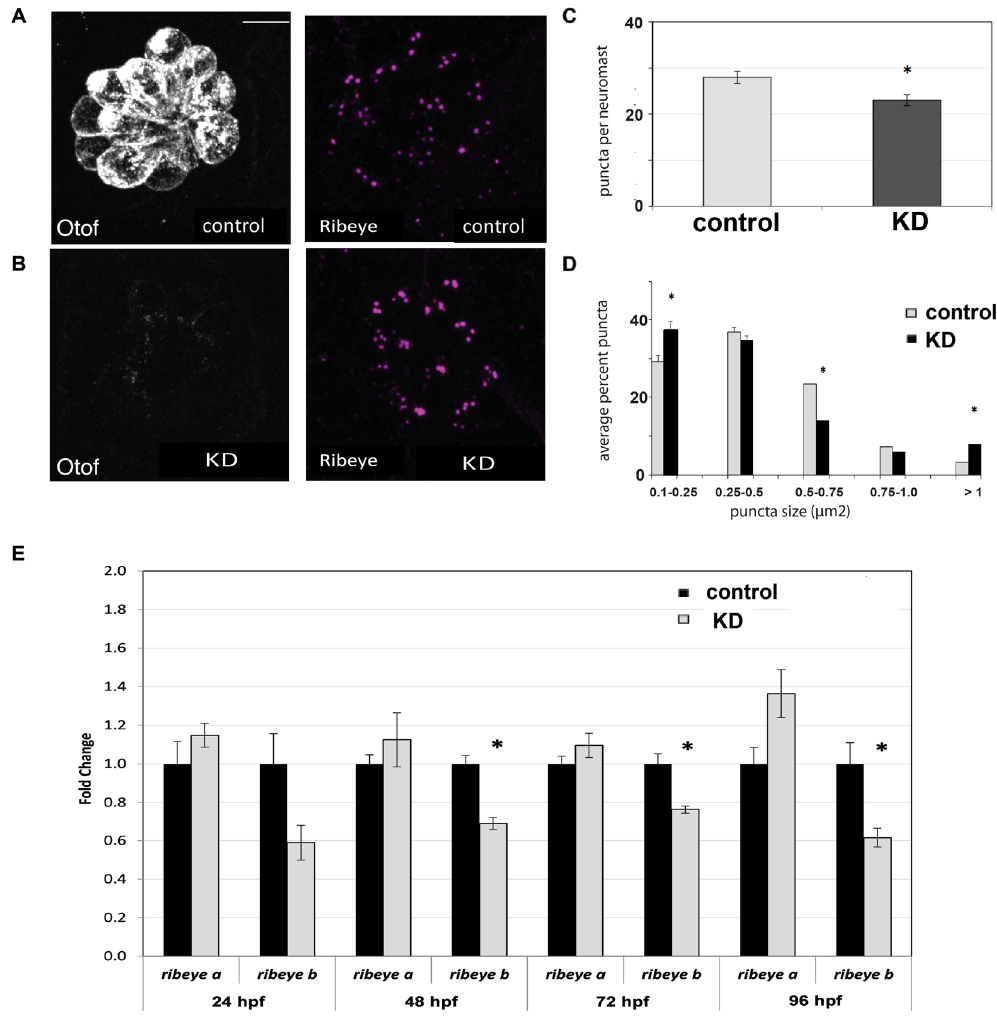
Figure 2. Effects of otoferlin depletion on synaptic morphology in posterior lateral line neuromasts of 96 hpf zebrafish larvae. ( A , B ) Representative confocal z-projection images of neuromasts from control injected ( A ) and otoferlin morphant ( B ) larvae immunolabeled with anti-otoferlin (HCS-1), and anti-Ribeye. ( C ) Average number of Ribeye puncta counted per neuromast in negative control injected (no. of neuromasts = 20) and morphant (no. of neuromasts = 18) larvae (t-test, p-value < 0 . 0001) . Error bars indicate s.e.m. ( D ) Average percent of Ribeye puncta per neuromast that fell within size bins of 0.1–0.25, 0.25–0.5, 0.5–0.75, 0.75–1.0, and > 1.0 µ m 2 , in control injected (no. of neuromasts = 20) and morphant (no. of neuromasts = 18) larvae (t-test, p-value < 0 . 0001) , Error bars indicate s.e.m. ( E ) Expression of ribeye transcripts in control and morphant larvae at 24, 48, 72, and 96 hpf, N = 4 per time point (t-test, p-value < 0.05). Scale bars = 5 µ